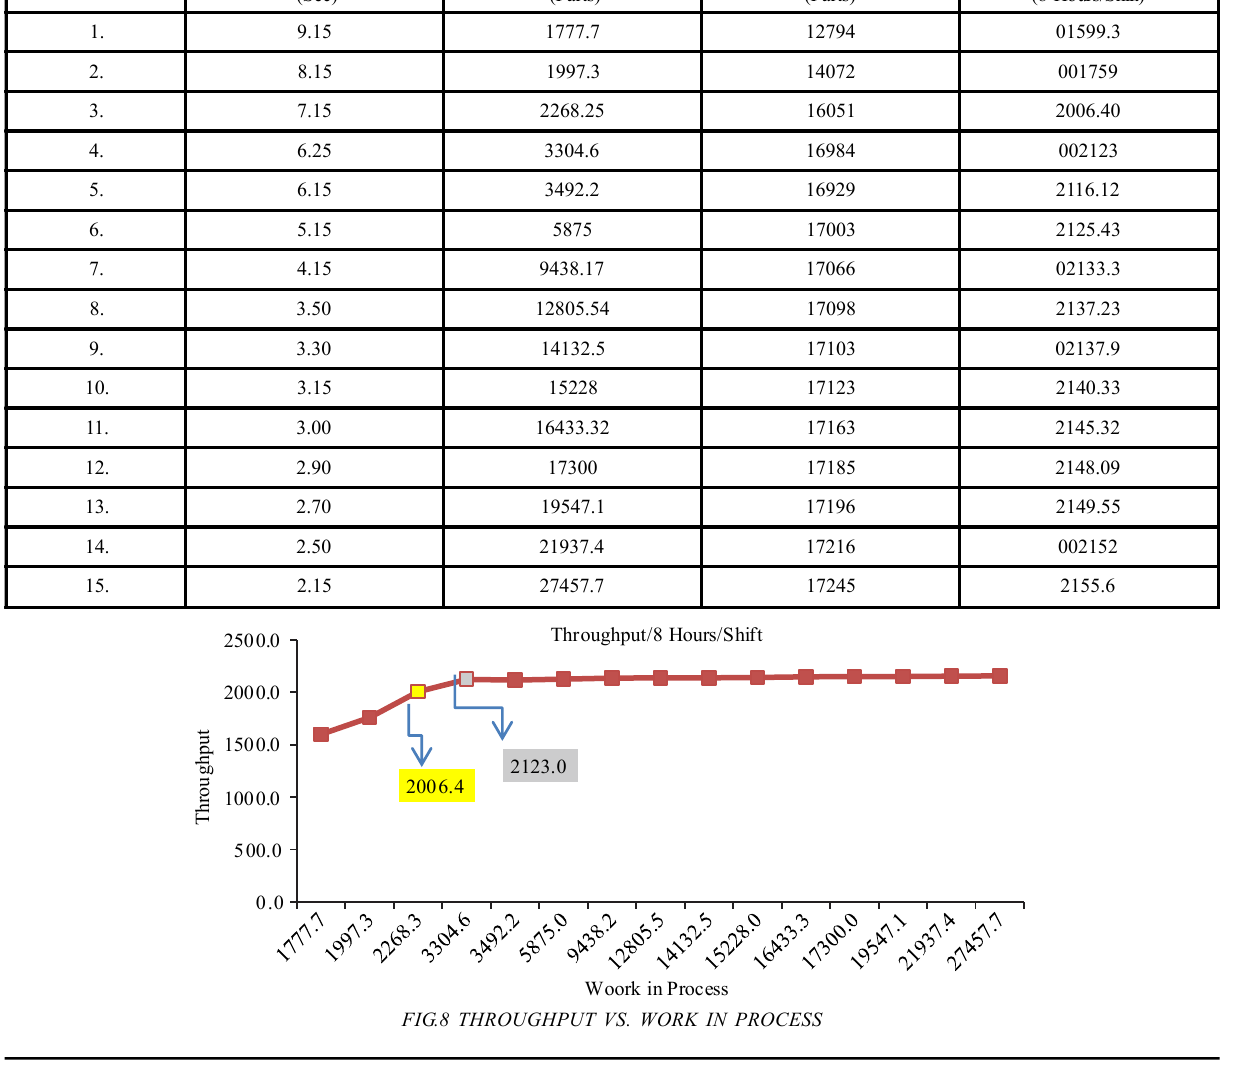
FIG.8 THROUGHPUT VS. WORK IN PROCESS